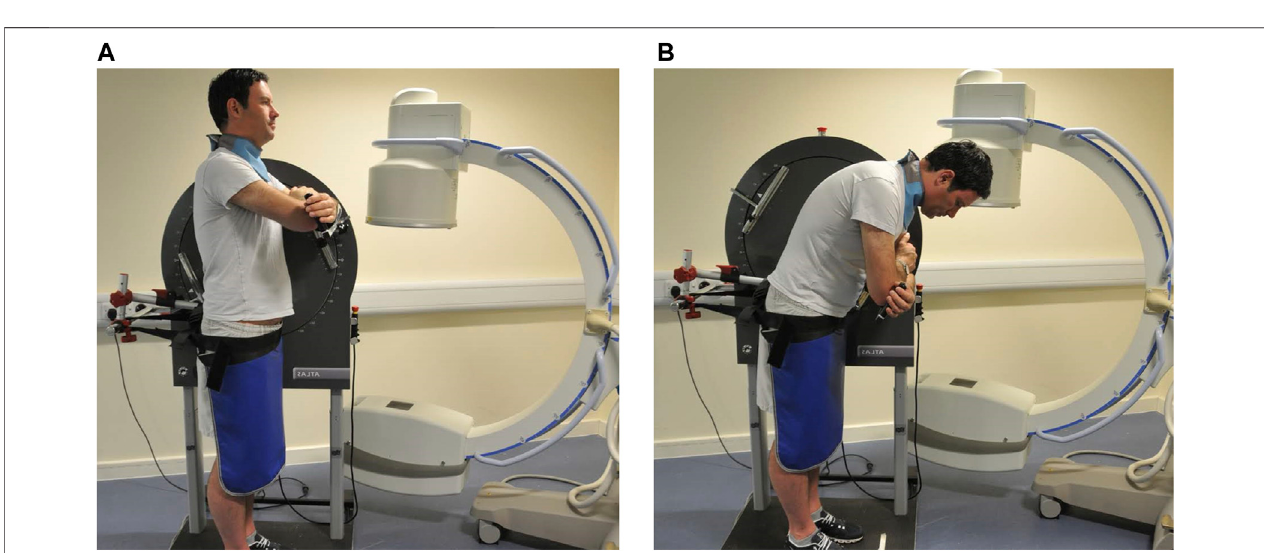
FIGURE 1 | Motion protocol used for fl uoroscopic image acquisition (Courtesy Atlas Clinical Ltd., Lich fi eld, United Kingdom) (A) upright (B) fl